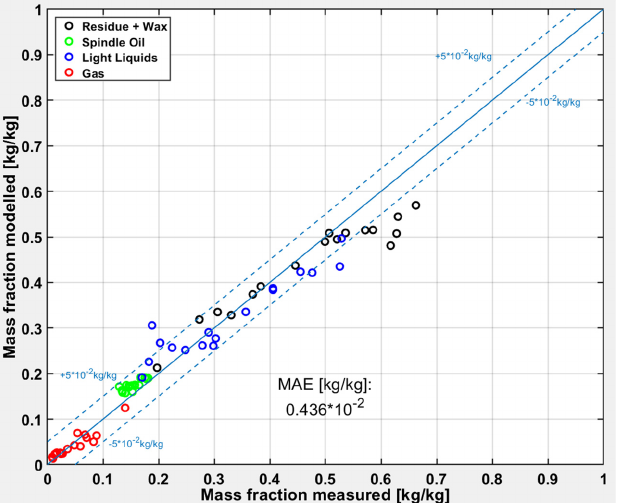
Figure 11. Deviation of the modeled and measured values of the test runs with carrier fluid and HDPE. “MAE” is the mean absolute error of the optimization of 0.44 × 10 − 2 kg/kg. The dashed lines show the 10% deviation.